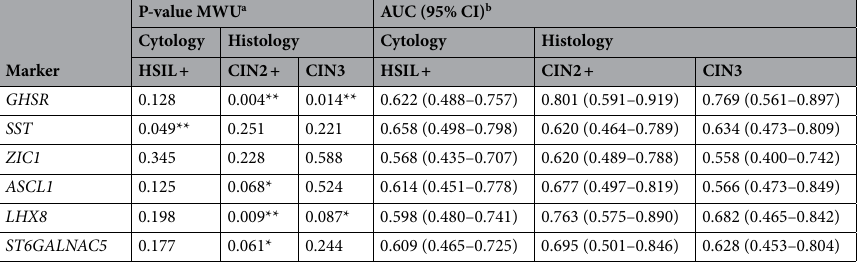
Table 1. Performance of individual host cell methylation markers to discern high-grade cervical disease. Performance of each marker was assessed using cytology (HSIL + , n = 89) and histology (CIN2 + and CIN3, n = 33) as reference. a P-values (Mann Whitney U-test (MWU)) indicated by a double asterisk indicate that the null hypothesis (H0) is rejected (p ≤ 0.05) and that the median square root transformed methylation marker ratios between normal/low-grade and high-grade cervical disease are not equal. P-values values indicated by a single asterisk indicate a trend (0.05 < p ≤ 0.10). b An estimation of the performance of each marker was evaluated by the area under the curve (AUC) and accompanying 95% confidence interval